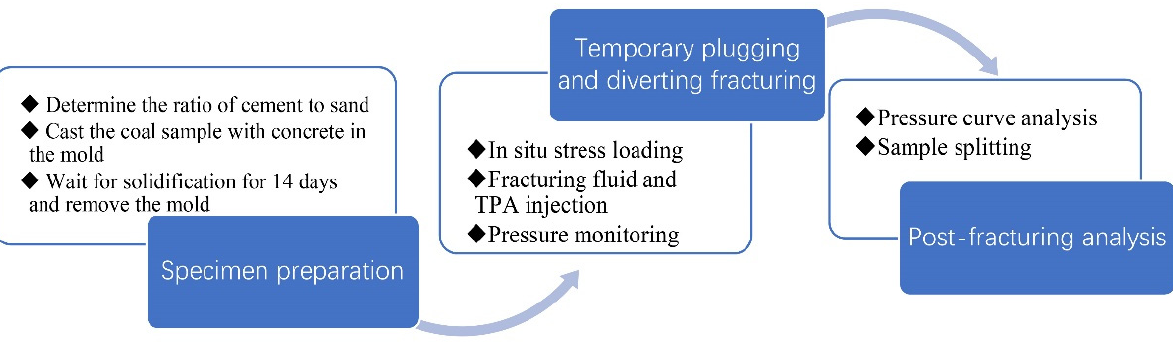
Figure 4. The flow chart of the TPDF experiment.